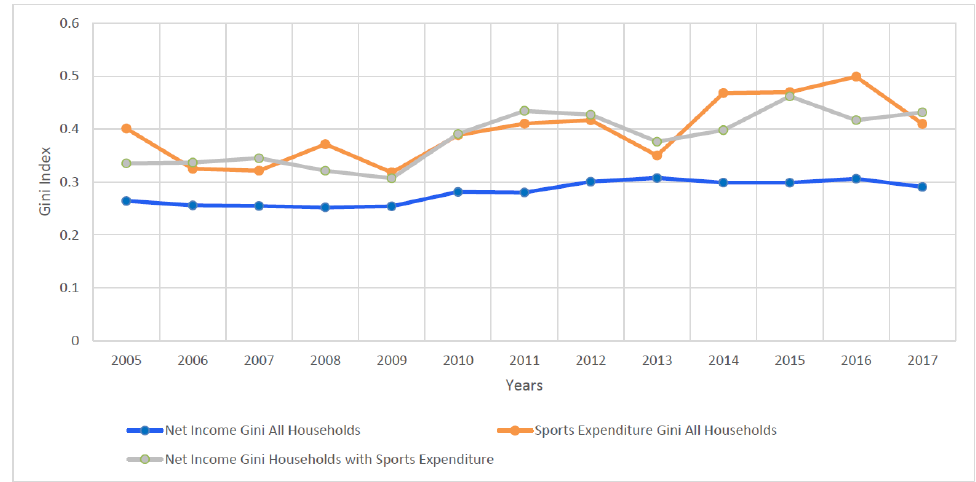
Figure A3. Gini inequality indices in the time period 2005–2017. Source: own calculation.